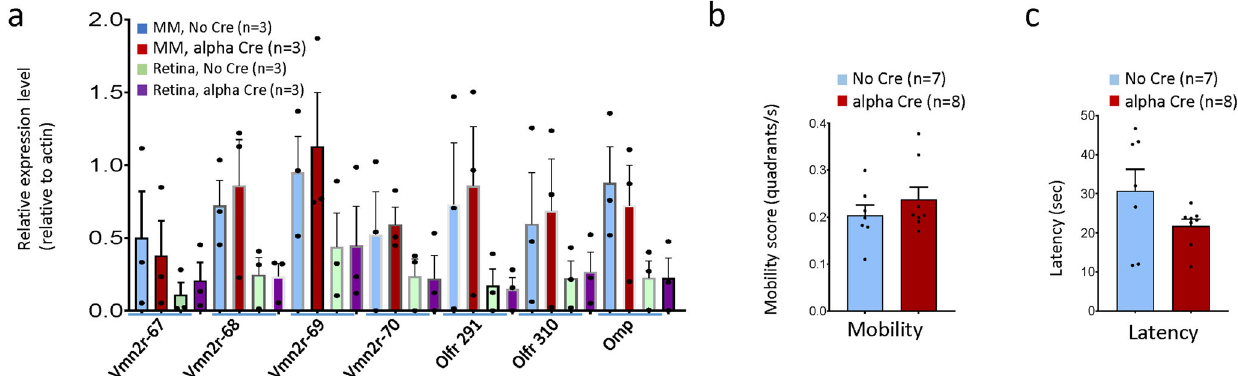
Fig. 7 Effects of the α -Cre transgenes on olfactory gene expression and function. a RT-PCR was used to assess expression of the indicated genes from nasal mucosa (NM) and retina of indicated genotypes at P13. b , c The mobility score ( b ) and the latency to fi nd buried pellets ( c ) of the indicated genotypes at P30. Error bars represent SE of measurements and asterisks indicate signi fi cant differences between indicated genotypes (* p < 0.05, ** p < 0.01, one-way ANOVA followed by Bonferroni sites 18 – 20 . The α -Cre transgene maps to 7qD3, in a cluster of Vmn2r GPCR genes, with loss of a 27 kb stretch. Relative to